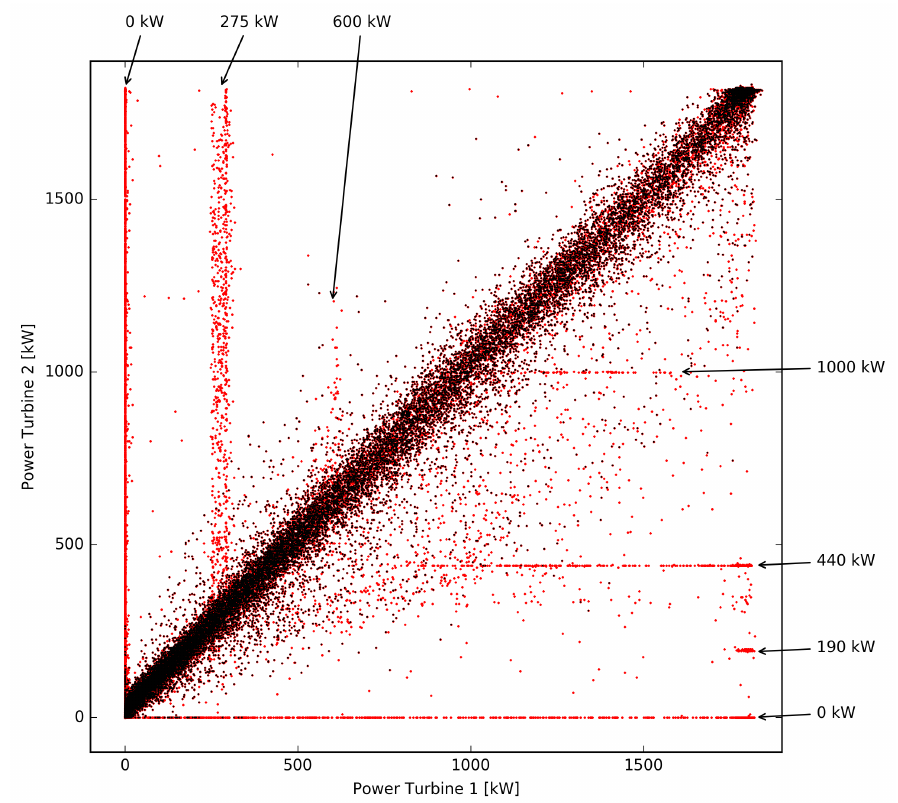
Figure 2. Comparison of the powers produced by the two turbines. Red dots refer to all available measurements, black dots to those filtered on the basis of the information provided by the plant